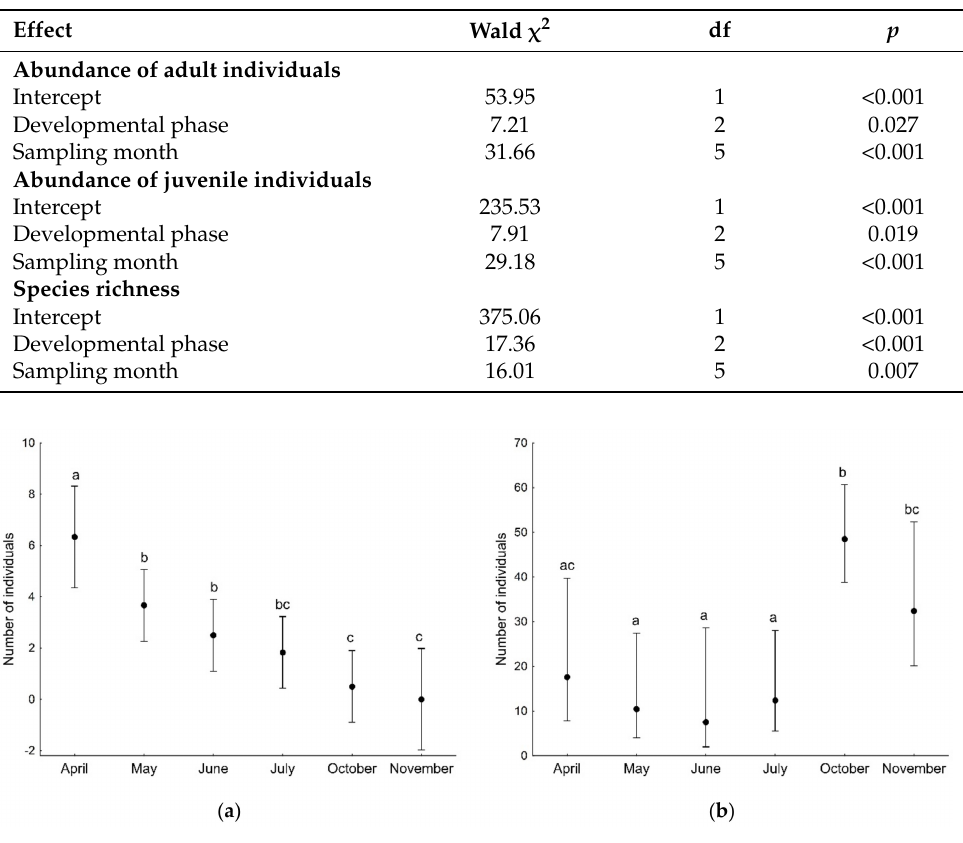
Figure 3. The number of adult ( a ) and juvenile ( b ) spider individuals (mean with 95% confidence limits) recorded on tree branches in particular sampling months. Different letters indicate significant differences between sampling months.